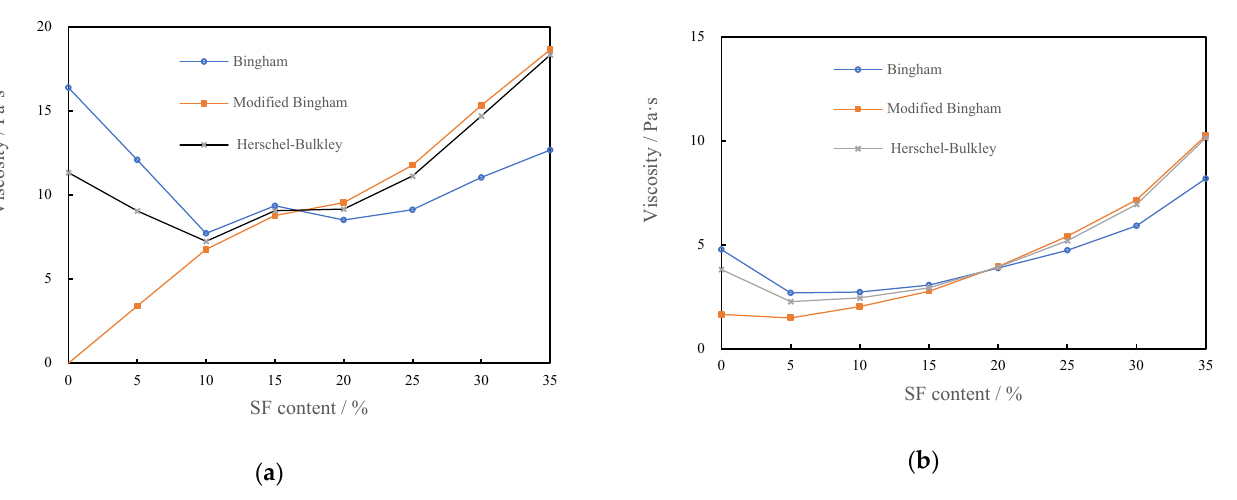
Figure 7. The relationship between the plastic viscosity and silica fume content, ( a ) W/B = 0.19 , ( b ) W/B = 0.23 .